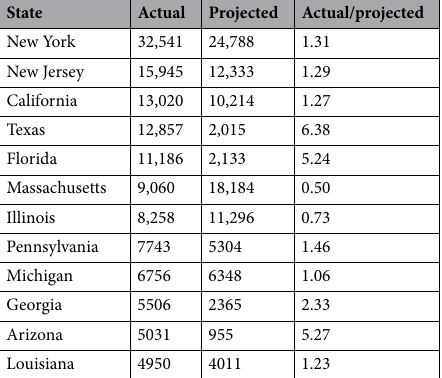
Table 1. The actual confirmed and the projected number of deaths by August 31st. The projected count is obtained by assuming the mitigation efforts in place at the end of April were maintained by the end of August. The last column is the factor of increase (if larger than 1) or decrease (if smaller than 1) of the actual death count when compared with the projection.